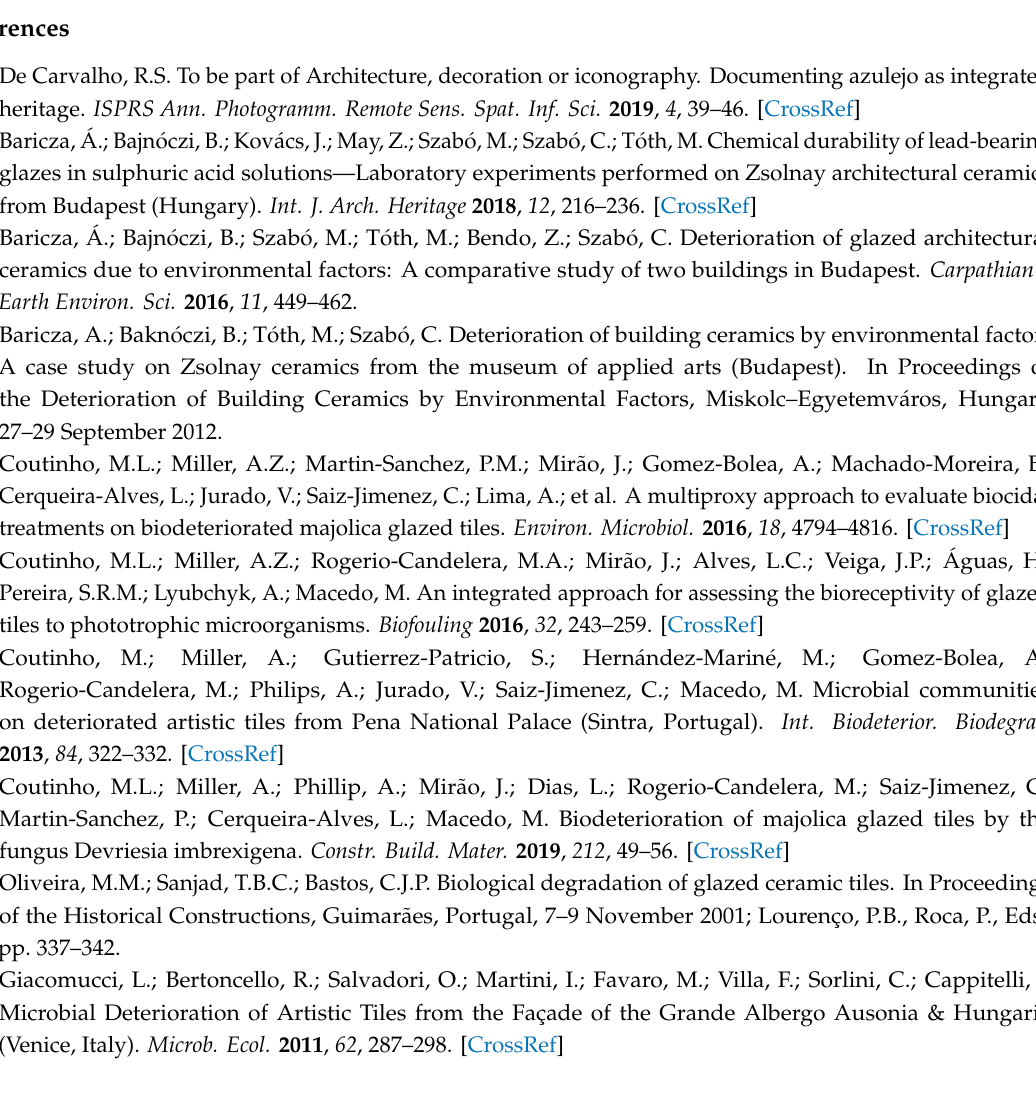
Figure S1: Scanning electron microscopy images of the surface of the TiO 2 -treated glazed tiles and Figure S2: Scanning electron microscopy images of the surface of glazed tile 1BW before and after 2 h exposure to HNO 3